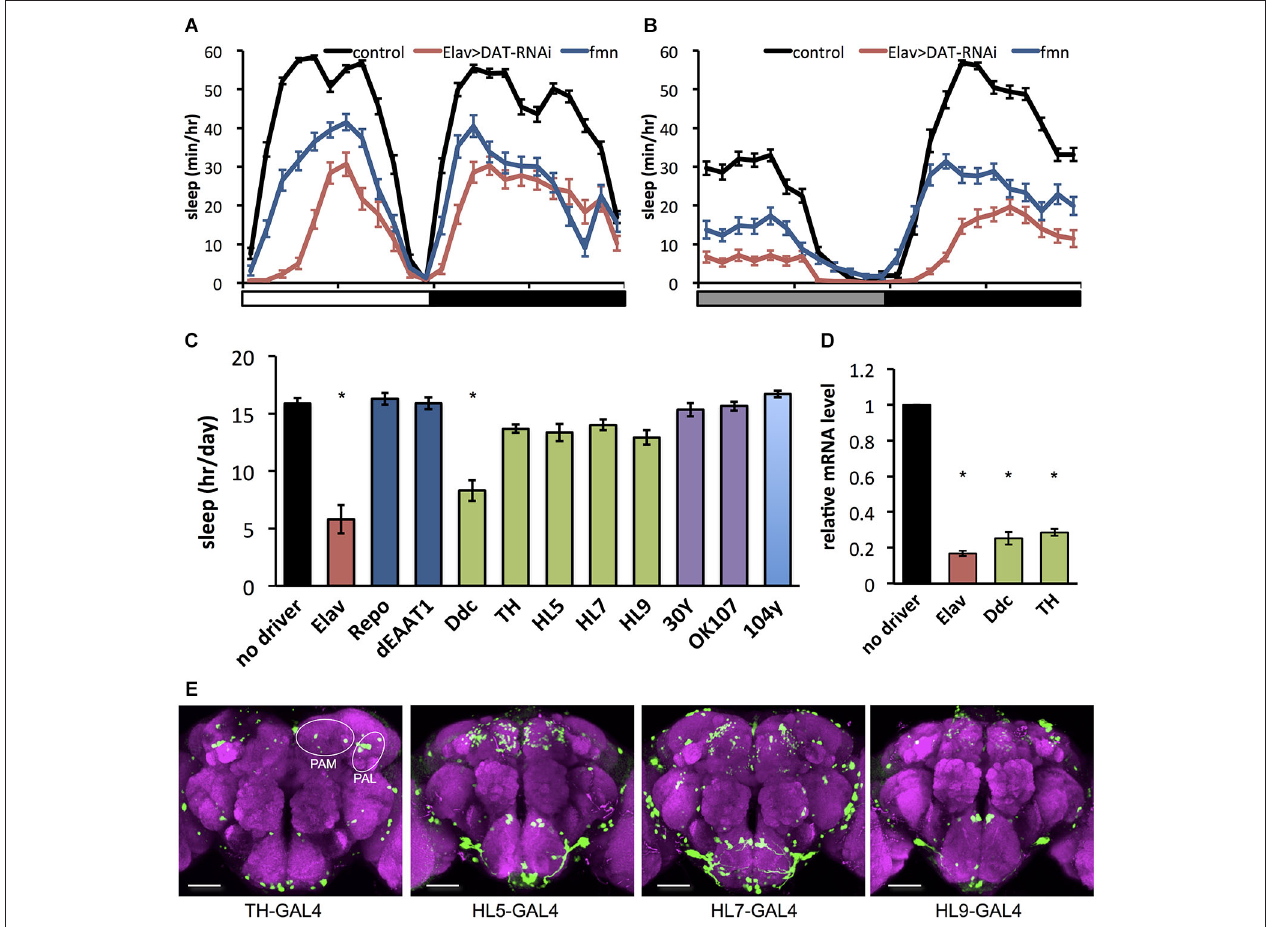
of dDAT knockdown. The expression levels of dDAT gene in the head of flies expressing dDAT RNAi transgene by GAL4 drivers are expressed as the relative values to the control flies. n = 3 for each group. Data are represented as the mean ± s.e.m. * P < 0.05; one-way ANOVA with Tukey-Kramer HSD post hoc test. (E) Expression patterns of GAL4 drivers for dopaminergic neurons in the central brain. The GAL4 expression for each driver was visualized using UAS-mCD8::GFP (green). The brain was stained with antibody to nc82 to stain the neuropil (magenta). PAM, protocerebral anterior medial; PAL, protocerebral anterior lateral. Scale bars = 50 µ